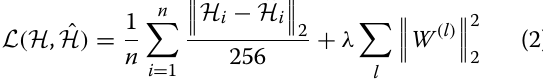
ˆ H where H and respectively denote a batch of n input vectorized histograms of 256 elements and their recon- struction, W ( l ) indicates weights of the fully connected layer in block l , and λ is the regularization rate that controls the effect of W s on the total loss L .